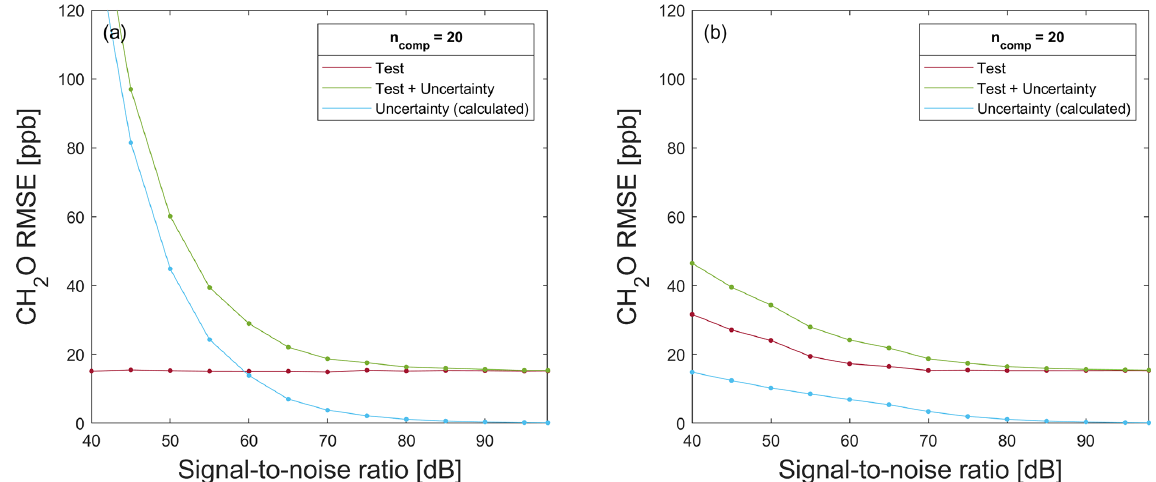
Figure A8. RMSE for testing of a model trained with 80% (a) raw data and (b) noisy data (added white uniform noise to raw data) for a formaldehyde prediction on 20% test data without (red) and with associated uncertainty values (green), in addition to the calculated uncertainty RMSE (blue) resulting from the difference in T + U − RMSE and T − RMSE.